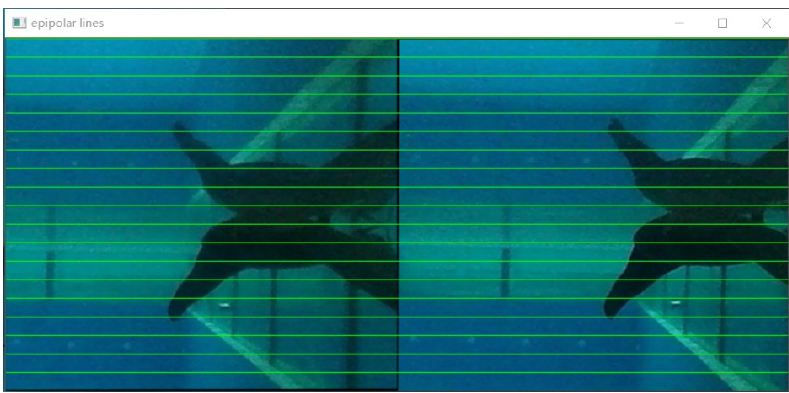
Figure 5. Image after stereo